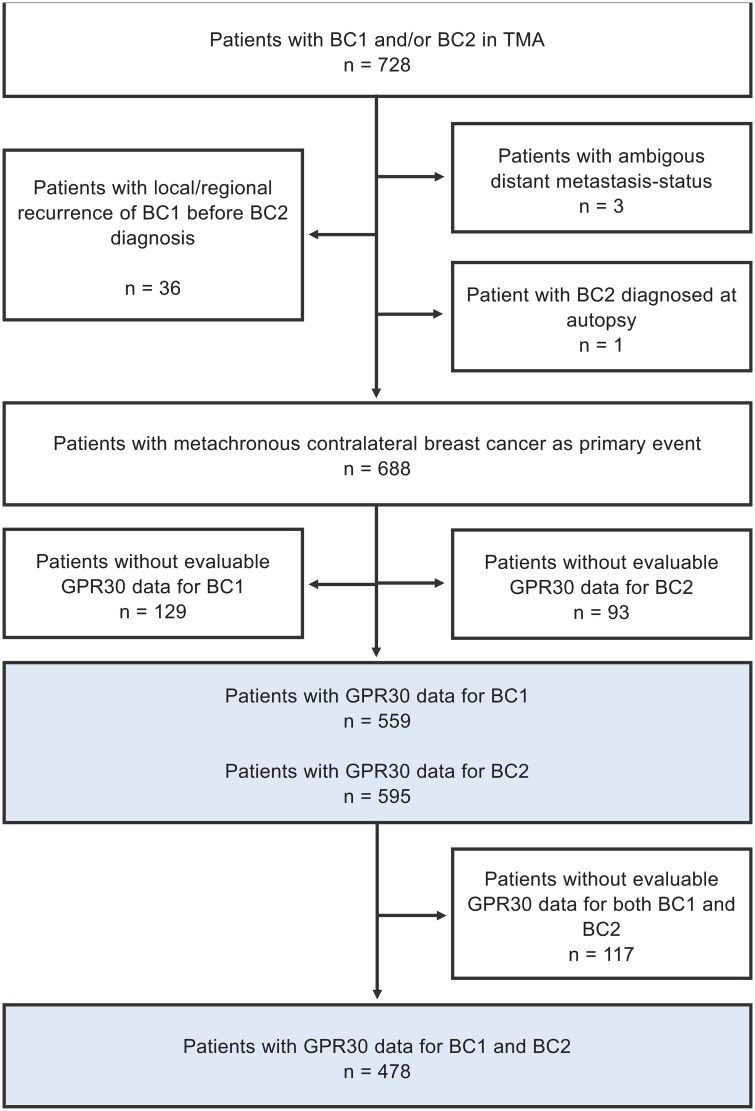
Flow-chart of inclusion and exclusion for the study cohort.